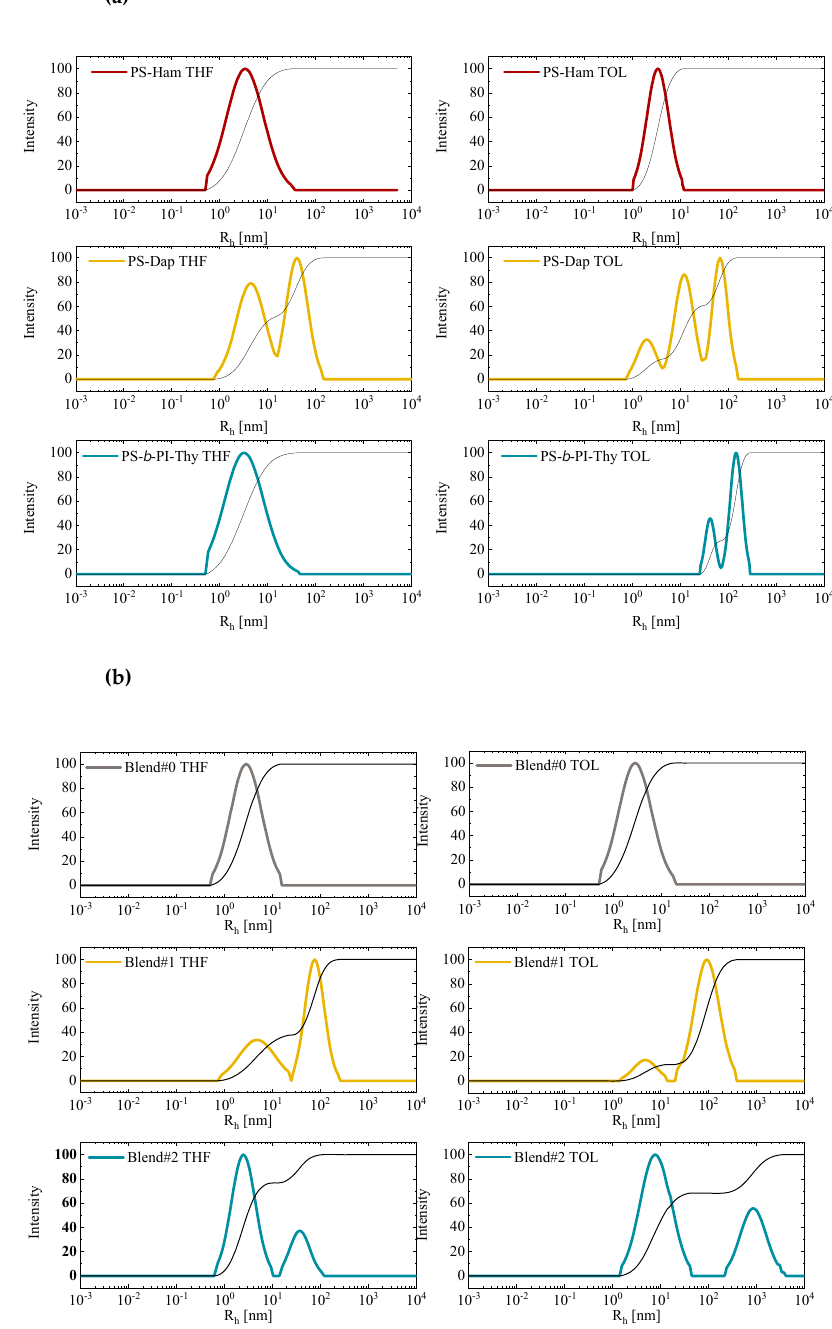
Figure15. CONTINanalysisofPS-Ham, PS-Dap, PS- b -PI-Thy, ( a )andofBlend#0, Blend#1, andBlend#2 ( b ) in THF and toluene, at 25 ◦ Figure 15. CONTIN analysis of PS ‐ Ham, PS ‐ Dap, PS ‐ b ‐ PI ‐ Thy, ( a ) and of Blend #0, Blend #1, and Blend #2 ( b ) in THF and toluene, at 25 °C.